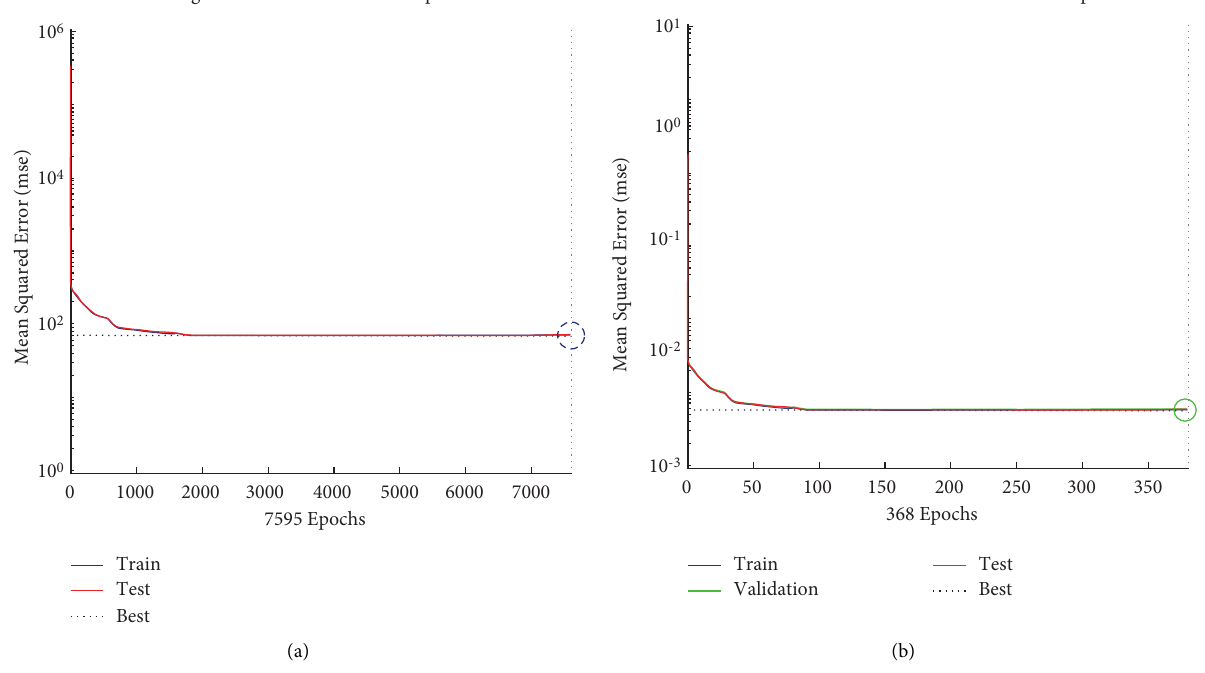
Figure 9: (a, b) High difference in training results of performance after using data camera coordinate to determine the goal position “angle and distance,” and one output to the servo motor to determine the mobile robot movement angle. ( Supplementary Materials )